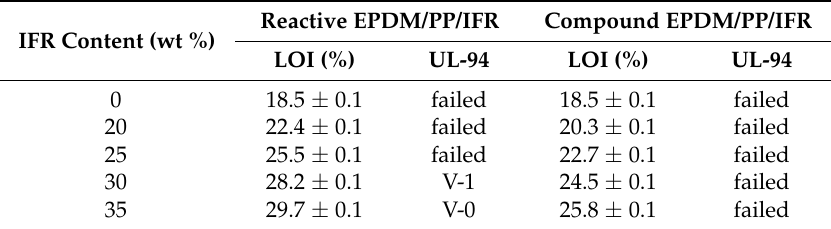
Table 3. The LOI and UL-94 levels of reactive extruded and compound EPDM/PP/IFR composites with different IFR (MP/PER) contents.